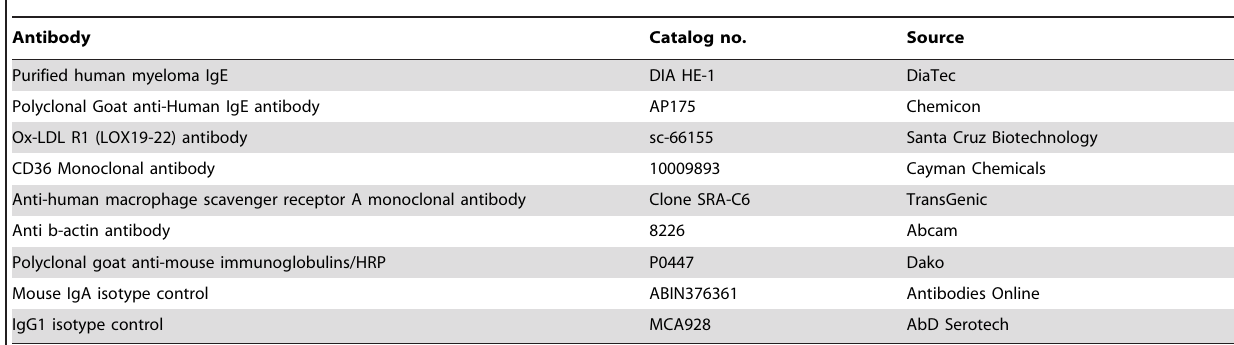
Table 1. Antibodies used in the